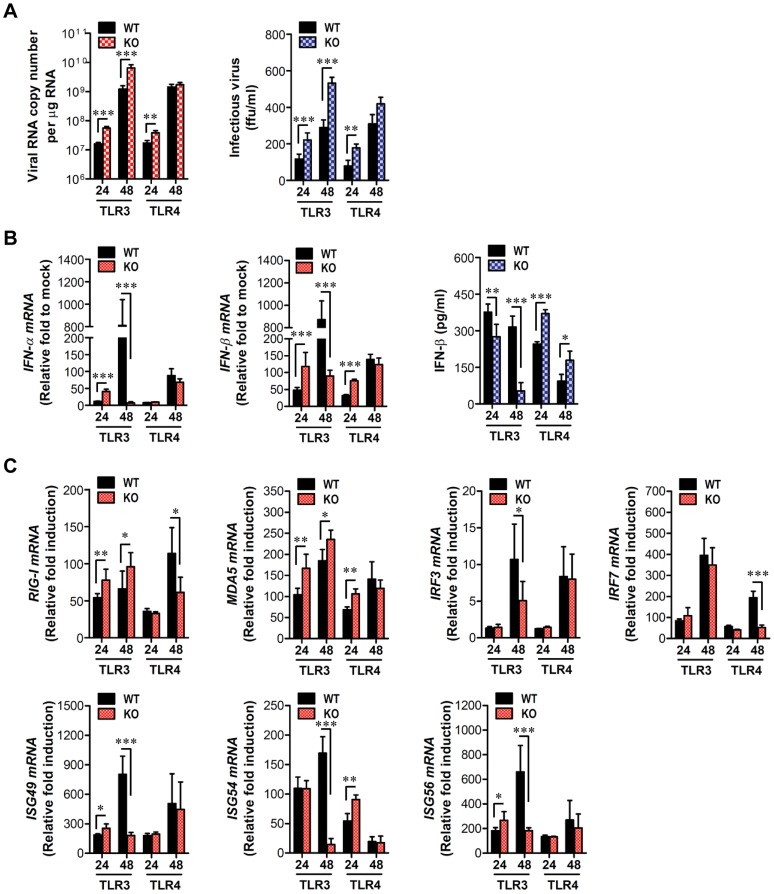
Induction of type I IFNs and ISGs in primary cortical neurons derived from TLR3−/− and TLR4−/− mice after JEV infection.Primary cortical neurons generated from TLR3−/− and TLR4−/− mice were infected at an MOI of 0.1, and viral replication and type I IFNs responses at 24 and 48 h pi were analyzed. A. JEV replication. JEV replication was determined by both real-time qRT-PCR and focus-forming assay. B. The expression of type I IFNs (IFN-α and IFN-β) mRNA and IFN-β secretion in primary cortical neurons infected by JEV. C. Induction of IRFs, ISGs, and RLRs gene in infected primary cortical neurons. The mRNA levels of the indicated gene were determined by real-time qRT-PCR, and IFN-β levels in culture media were determined by ELISA. Data represent the average ± SD derived from primary cortical neurons quadruplicate. *, p<0.05; **, p<0.01; ***, p<0.001 compared with the levels of the indicated group.